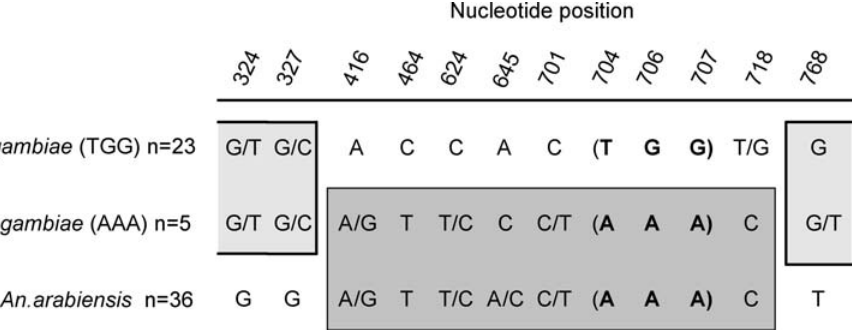
Figure 2. Shared polymorphism ofLRIM1in An.gambiae(TGG),An.gambiae(AAA), andAn.arabiensis. Only sites beyond position 324 that favor the clustering of An. gambiae (AAA) alleles with either An. gambiae (TGG) or An. arabiensis are